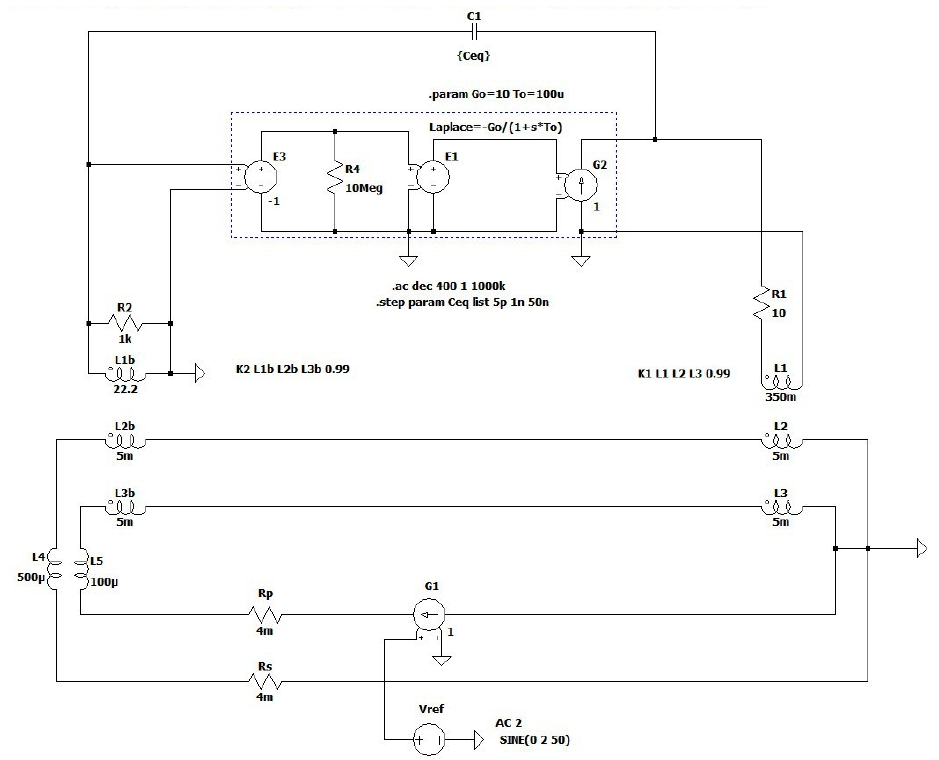
Figure 6. Equivalent EECT scheme with simplified control and compensating networks of the original TC amplifier.